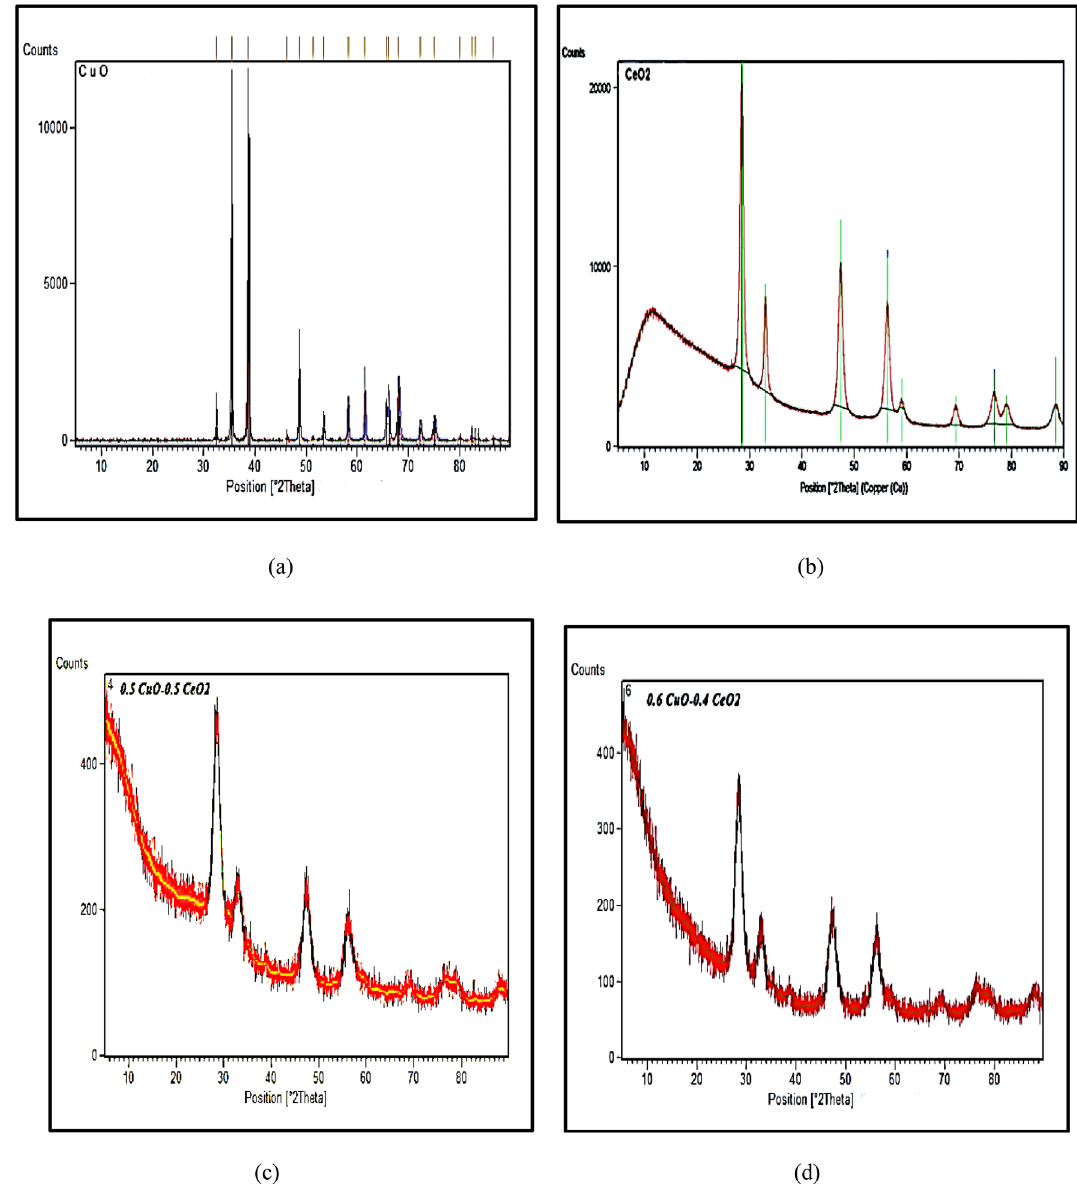
Figure 6. XRD Pattern of ( a ) Pure CuO, ( b ) Pure CeO 2 , ( c ) 0.5% CuO, 0.5% CeO 2 , ( d ) 0.6% CuO, 0.4% CeO 2